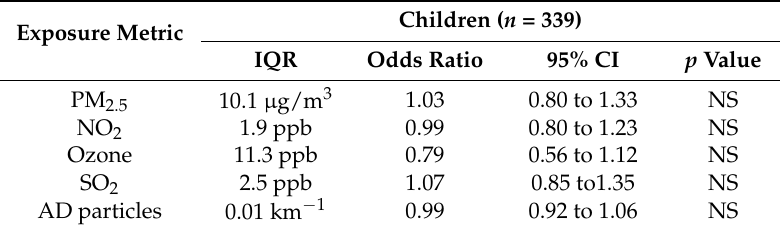
Table 3. Multivariate analysis using generalized estimating equation (GEE) logistic regression models to assess the association between skin symptoms and interquartile range (IQR) changes in the air contaminant concentrations.